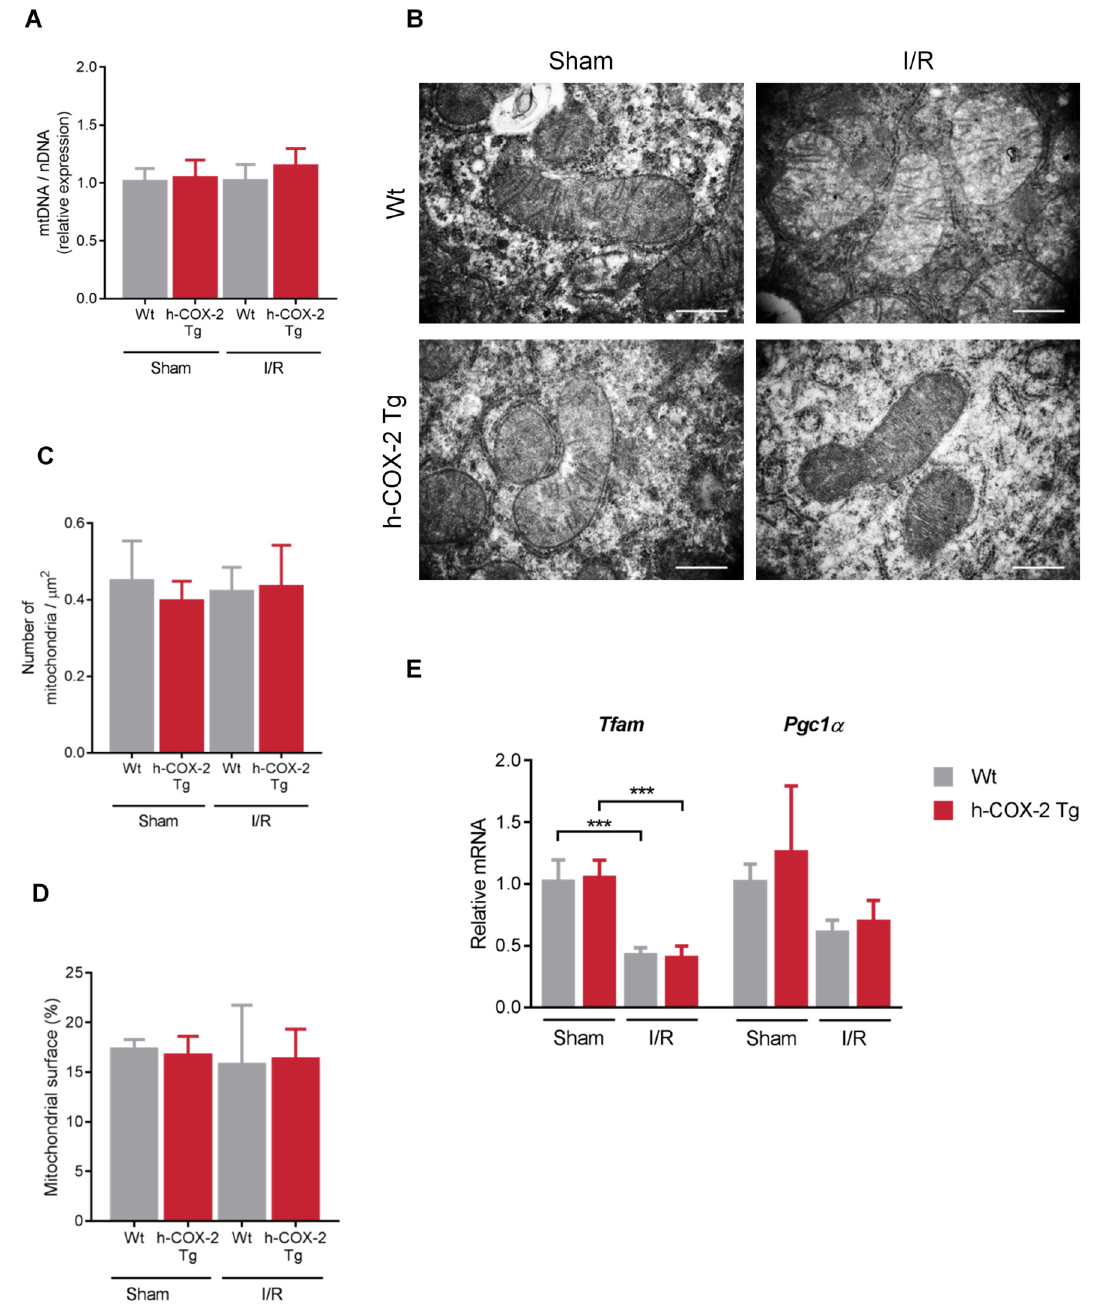
Figure 4. Study of the number and distribution of mitochondria in liver tissue after Sham or I/R surgery in the liver of Wt and h-COX-2 Tg mice. ( A ) Copy number of mitochondrial DNA ( CytB ) relative to nuclear DNA ( ApoB ) assessed by qPCR. Bars are means ± SD of 4–9 independent mea- surements. ( B ) Representative transmission electron microscopy images of liver sections from the four experimental groups. Original magnification × 25k. Scale bar: 500 nm. ( C ) Number of mito- chondria relative to the image area and ( D ) relative surface area occupied by mitochondria. Bars are means ± SD of 5 images per animal, from 3–5 animals per condition. ( E ) Hepatic mRNA levels of mitochondrial biogenesis genes ( Tfam and Pgc1 α ) in Sham and I/R conditions. Bars are means ± SD of 4 independent measurements. Statistical test: one-way ANOVA, followed by Tukey’s post-hoc test. *** p <